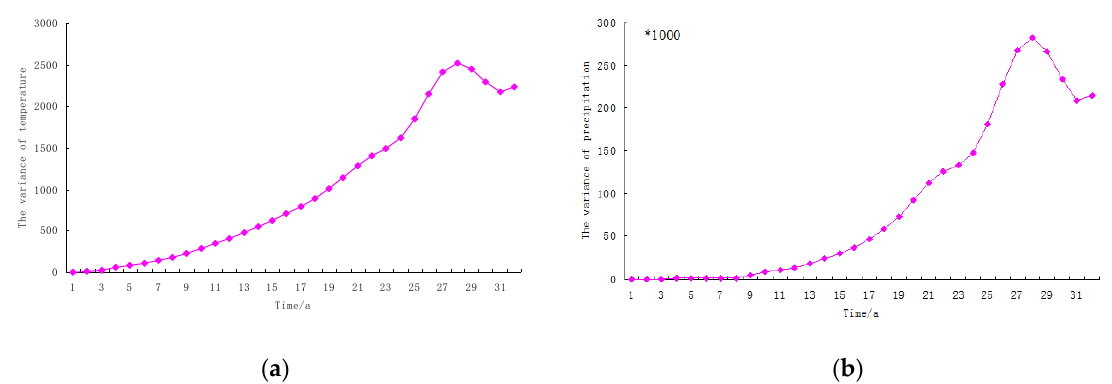
Figure 8. The characteristics of the wavelet variances of the annual temperature ( a ) and annual precipitation ( b ) in the summer and autumn seasons in Fujian from 1971 to 2018.